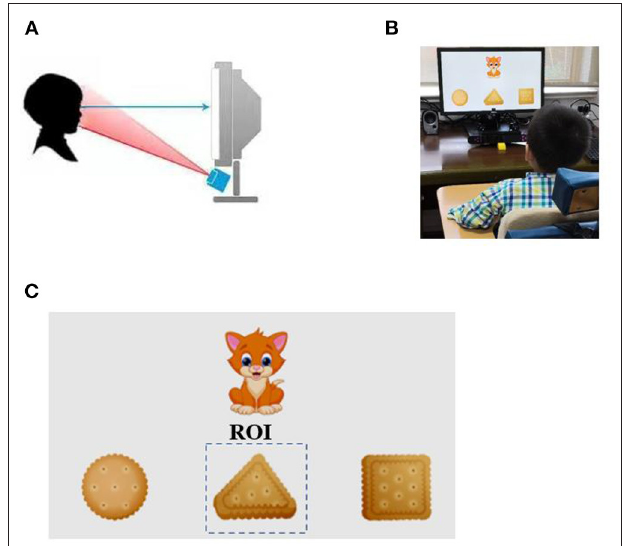
FIGURE 1 | Rapid cognitive assessment using eye-tracking technology. (A) The eye-tracking system used in the study. The gaze point of the subject was recorded using infrared light source and camera located below the monitor. (B) Legend of eye-tracking test for children. (C) An example of a working task and representative gaze